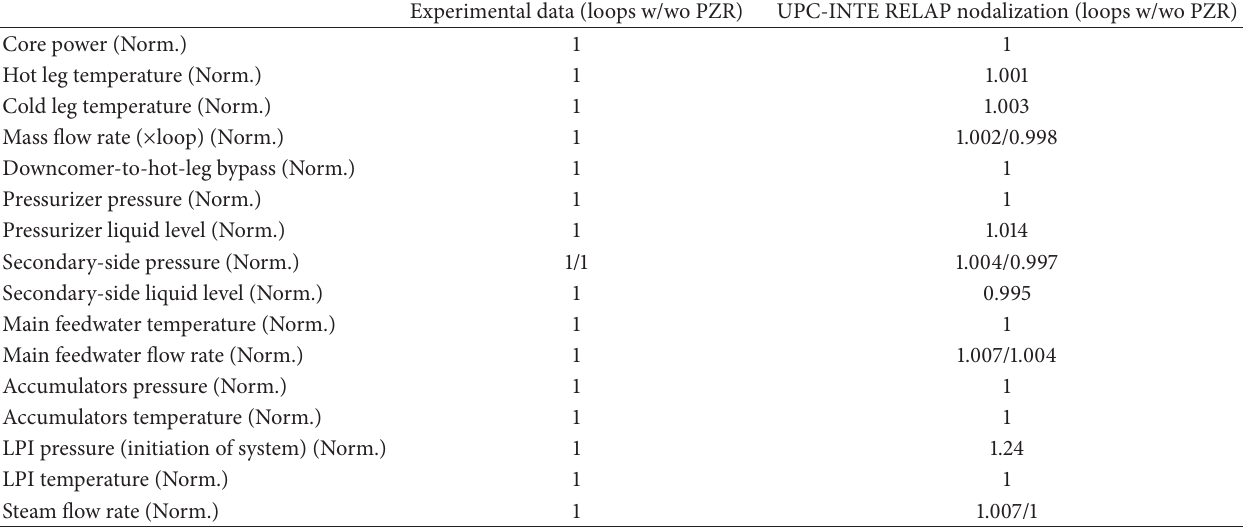
Table 5: Initial conditions of LSTF Test 3.